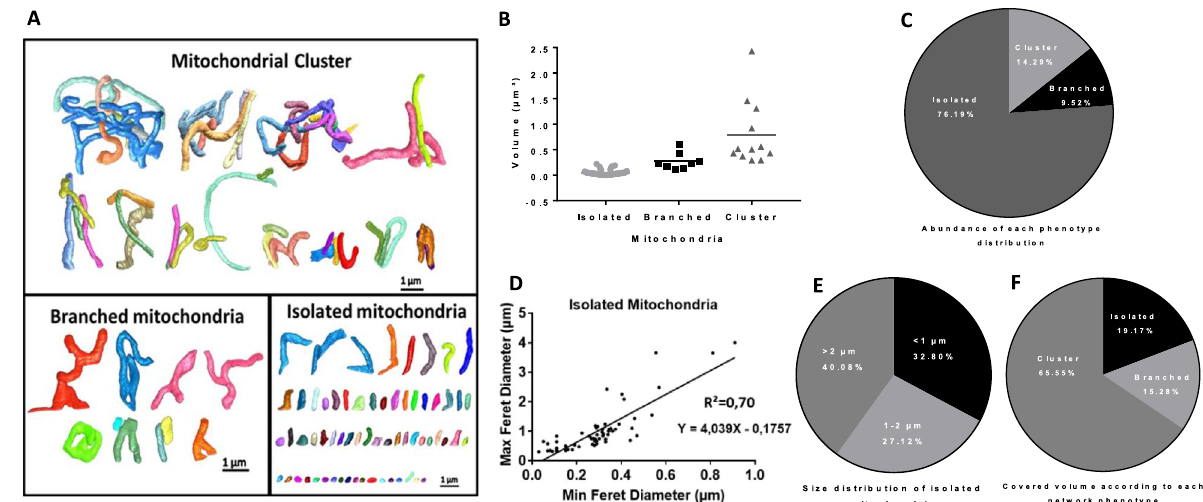
Figure 7. Mitochondrial parameters analysed with Dragonfly. ( A ) Network classification in to clustered, branched, and isolated forms. ( B ) Volume distribution of each mitochondrial category. ( C ) Abundance of each mitochondrial phenotype. ( D ) Relationship between Min ferret and Max ferret in isolated mitochondria. ( E ) Size distribution of isolated mitochondria. ( F ) Covered volume according to each mitochondrial